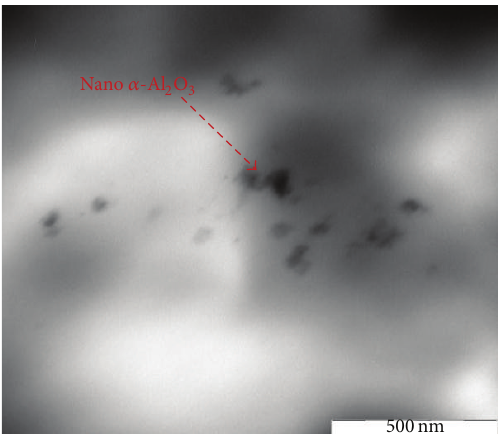
Figure 12: TEM observation of cryothin sectioning for PP/1% nano 𝛼 -Al 2 O 3 composites.